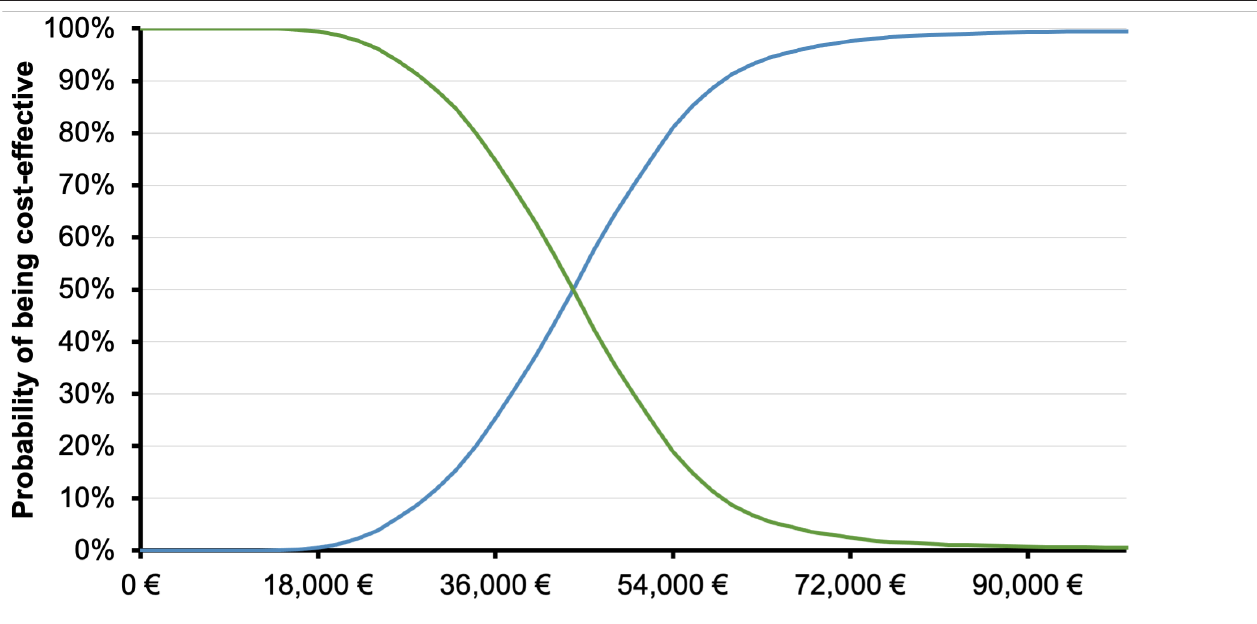
Figure 3. Cost-effectiveness Acceptability Curve: Loratinib vs